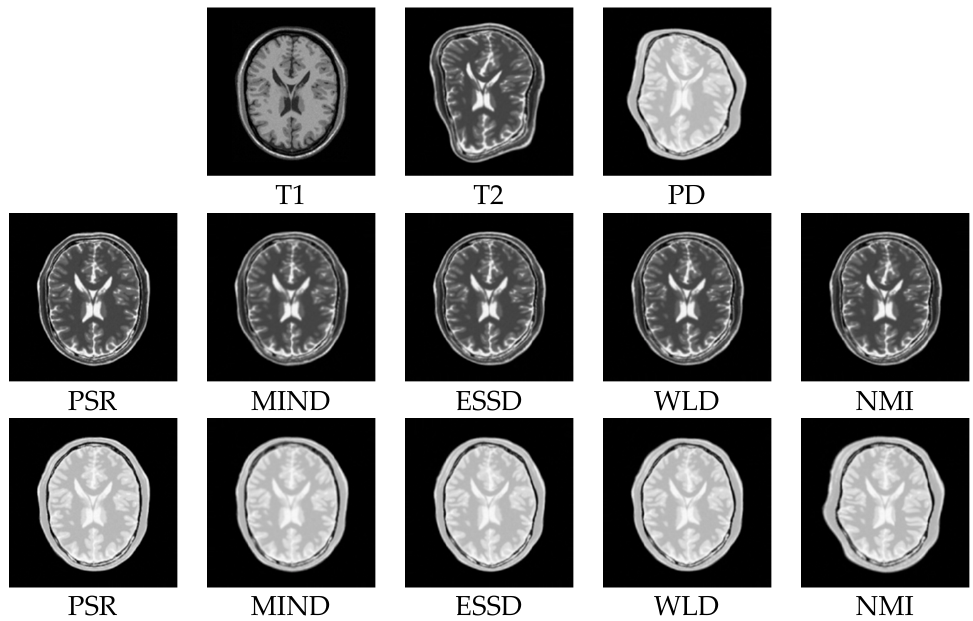
Figure 9. Registration results for the PSR, MIND, ESSD, WLD, and NMI methods performed on the BrainWeb dataset (T1–T2, T1–PD). The first row corresponds to the T1-weighted, T2-weighted, and PD-weighted MR images, respectively. The second row corresponds to the registered results of T1–T2 images for PSR, MIND, ESSD, WLD, and NMI, respectively. The third row corresponds to the registered results of T1-PD images for PSR, MIND, ESSD, WLD, and NMI, respectively.